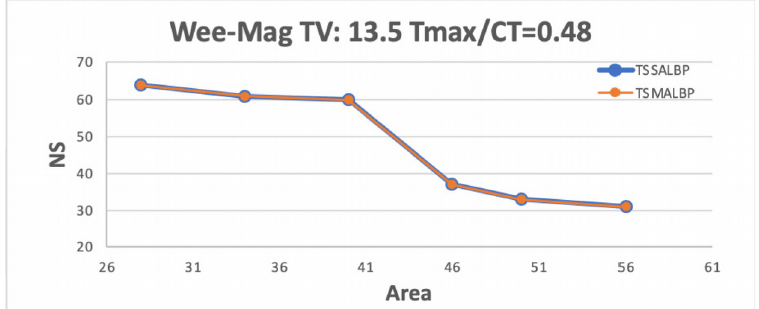
Figure 7. The number of stations drawn against the area for Wee-Mag instance with low TV and T